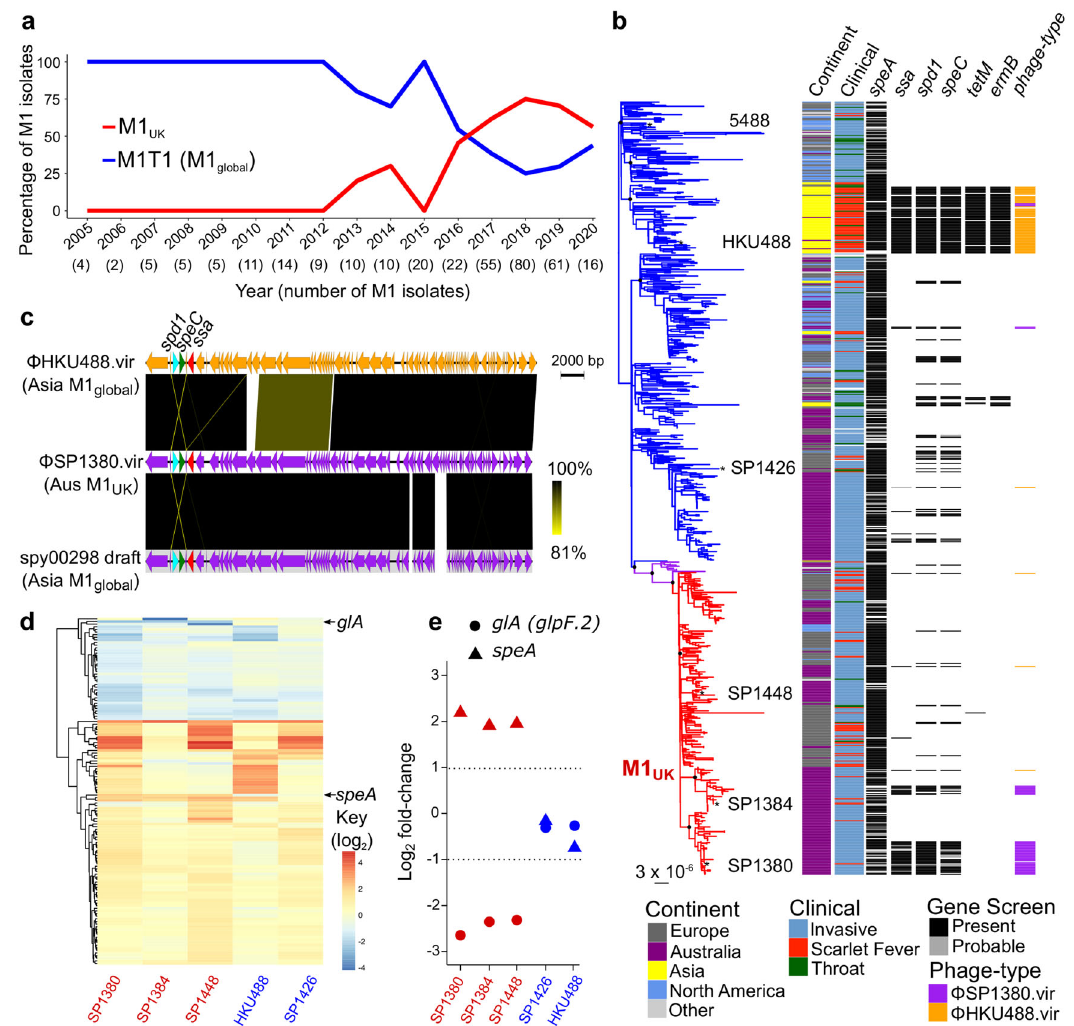
Fig. 1 | Characterization of M1 UK genotype in Australia. a Frequency of two M1 genotypes;M1 UK (red)andM1 global (blue)inrepresentativeclinicalspecimensfrom QueenslandandVictoriabetween2005and2019.De fi nitionofM1 UK isbasedonthe presence of 27 de fi ning SNPs and 4 indels (Supplementary Table 1). b Maximum- likelihood phylogenetic tree of 737 Australian and global M1 isolates built on 3465 SNP sites from a 1,623,078bp core genome alignment relative to the M1 global 5448 reference genome. Black circles at major branch nodes refer to >90% bootstrap support. Branches are coloured according to genetic sub-populations; ancestral M1 global (blue),intermediateSNPpro fi leM1 inter (purple),and27SNPand4deletions M1 UK (red). Selected type strains are annotated. Locality and clinical sample type are coloured as per legend provided. Carriage of bacteriophage-encoded toxin genes and antibiotic resistance determinants are indicated by black blocks, with contig fragmented hits indicated by grey blocks. c Pairwise tblastN comparison